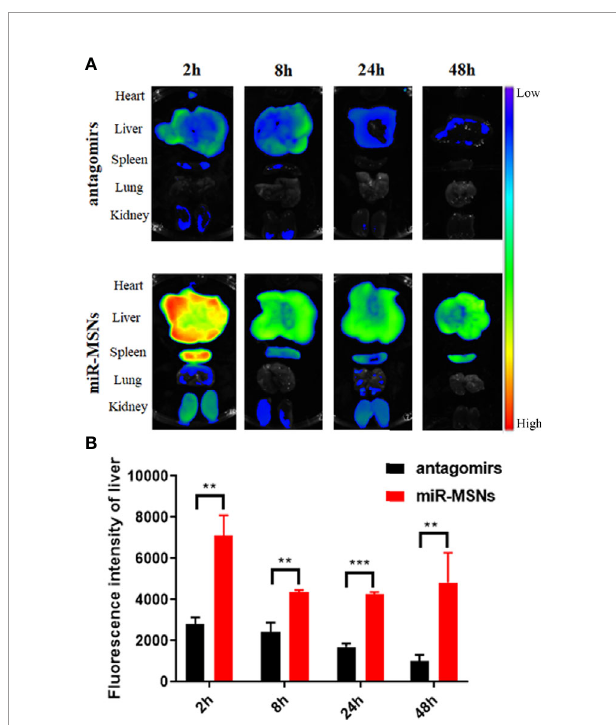
FIGURE 5 | Bio-distribution evaluation. n=3. (A) Ex vivo fl uorescence images of major organs (heart, liver, spleen, lung, and kidney) after administration. (B) Quantitative analysis of the distribution of miR-33 antagomirs in the liver. **p < 0.01, and ***p < 0.001.